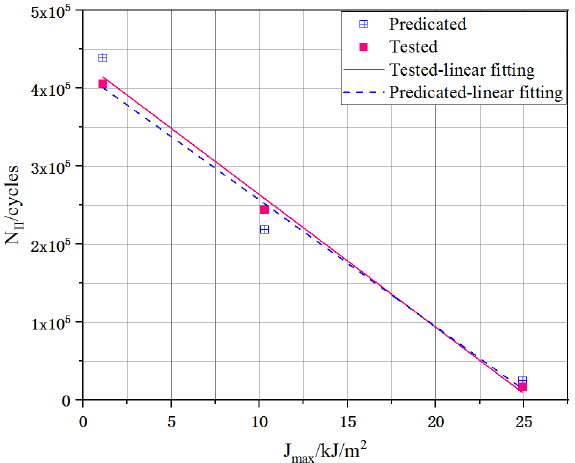
Figure 13. Comparison of the tested and predicated results of fatigue life during stages II.